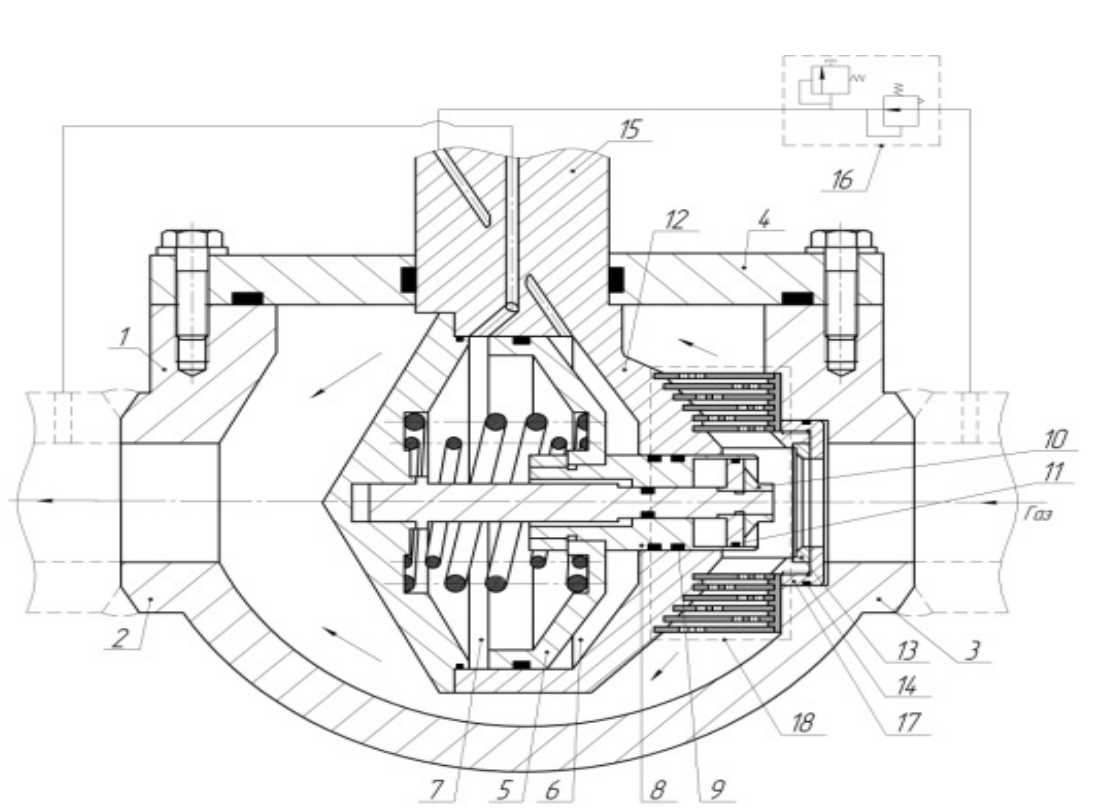
Figure A1. Investigated gas pressure regulator with built-in muffler (no 18).